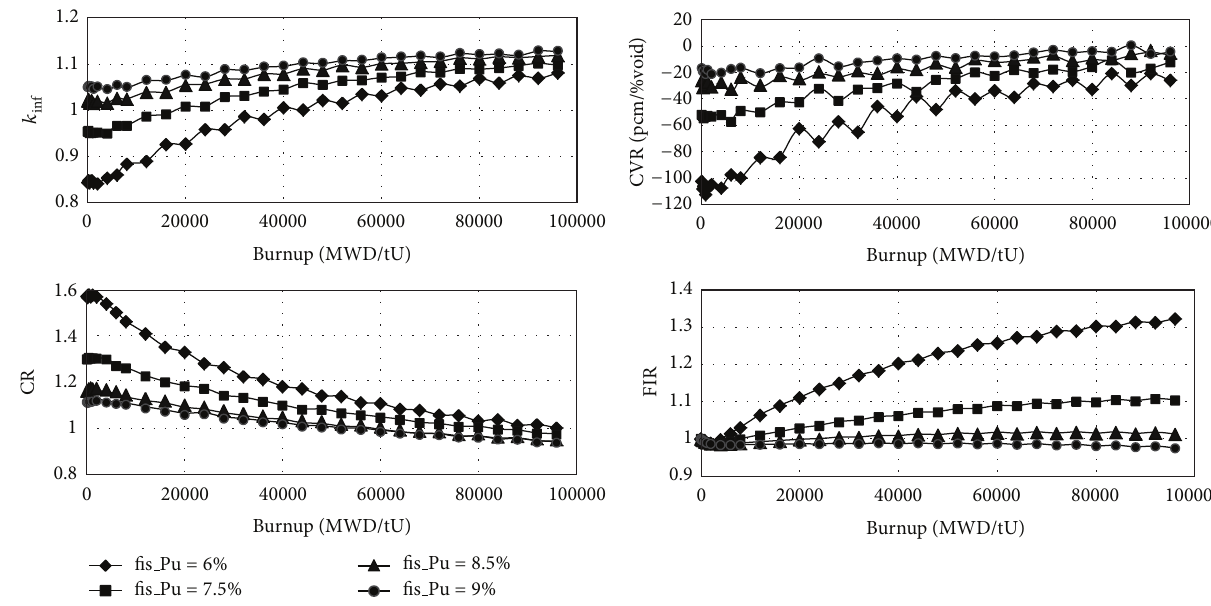
Figure 8: Inner cell burnup performances with Th-MOX fuel.